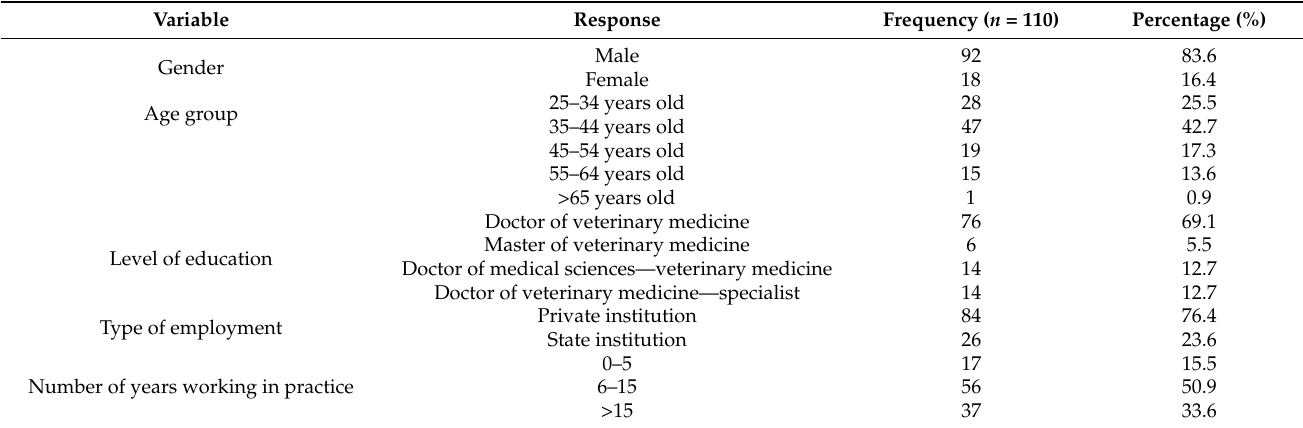
Table 1. Sociodemographic